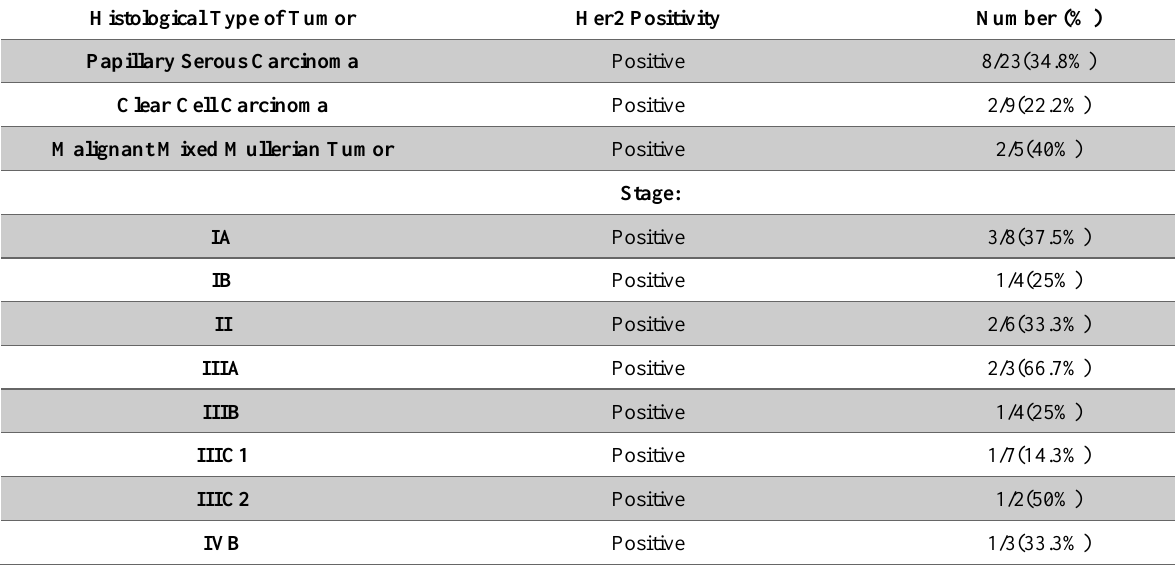
Table 2. Her2/neu positive according to histological type and stage